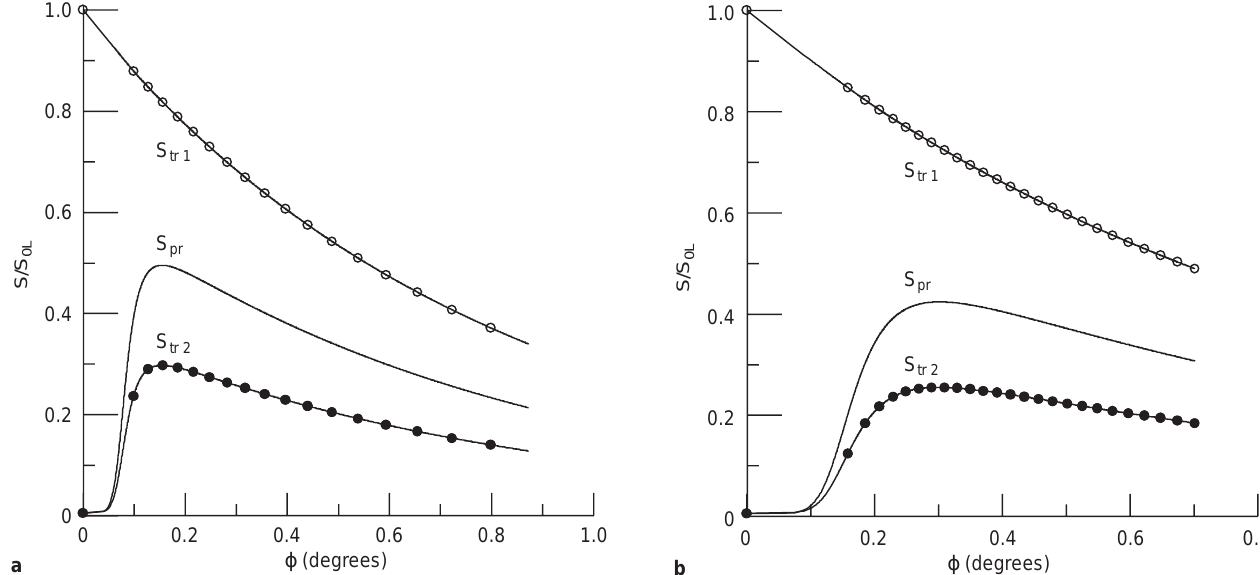
Fig. 3a, b. The dependence of fluxes of trapped and precipitated electron on u for strong di(cid:128)usion for di(cid:128)erent initial spread over energies: a D v = v 0 (cid:136) 0 : 3 ; b D v = v 0 (cid:136) 0 : 6 ; other parameters are as in